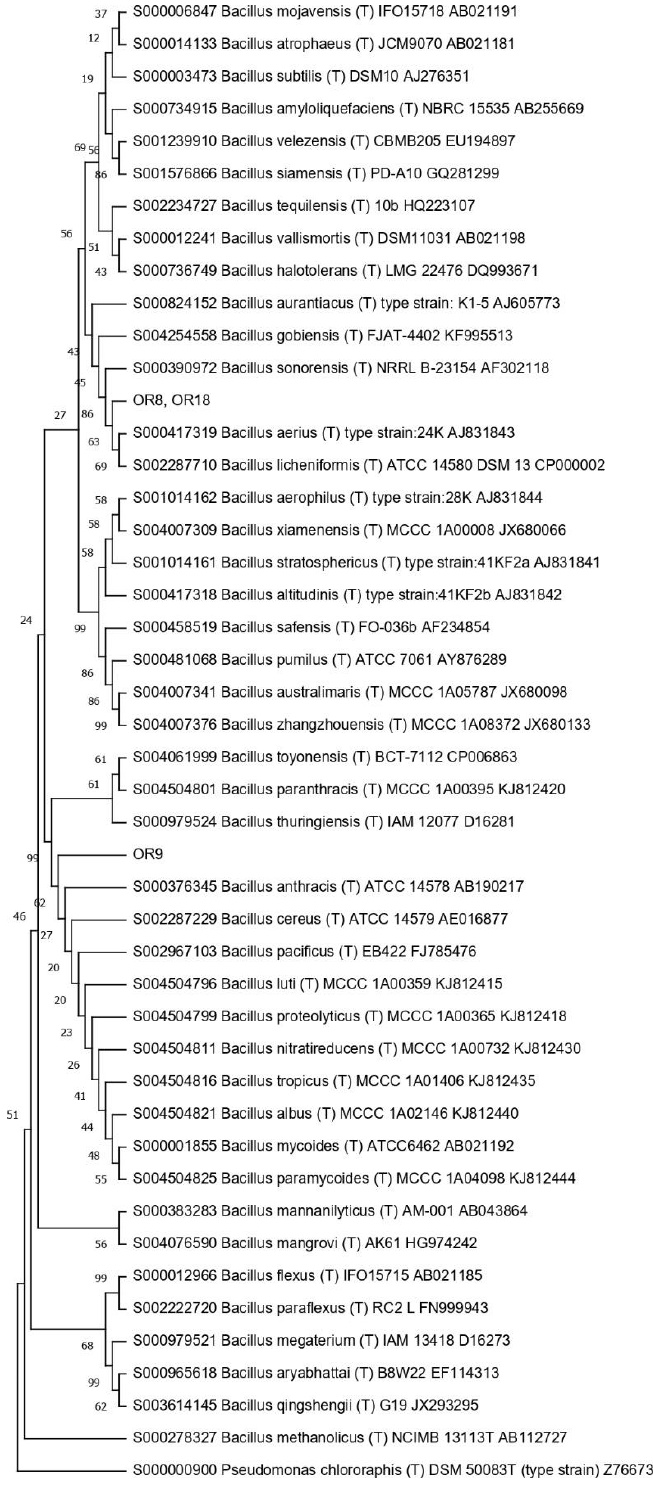
Figure 3. Phylogenetic tree for the genus Bacillus.